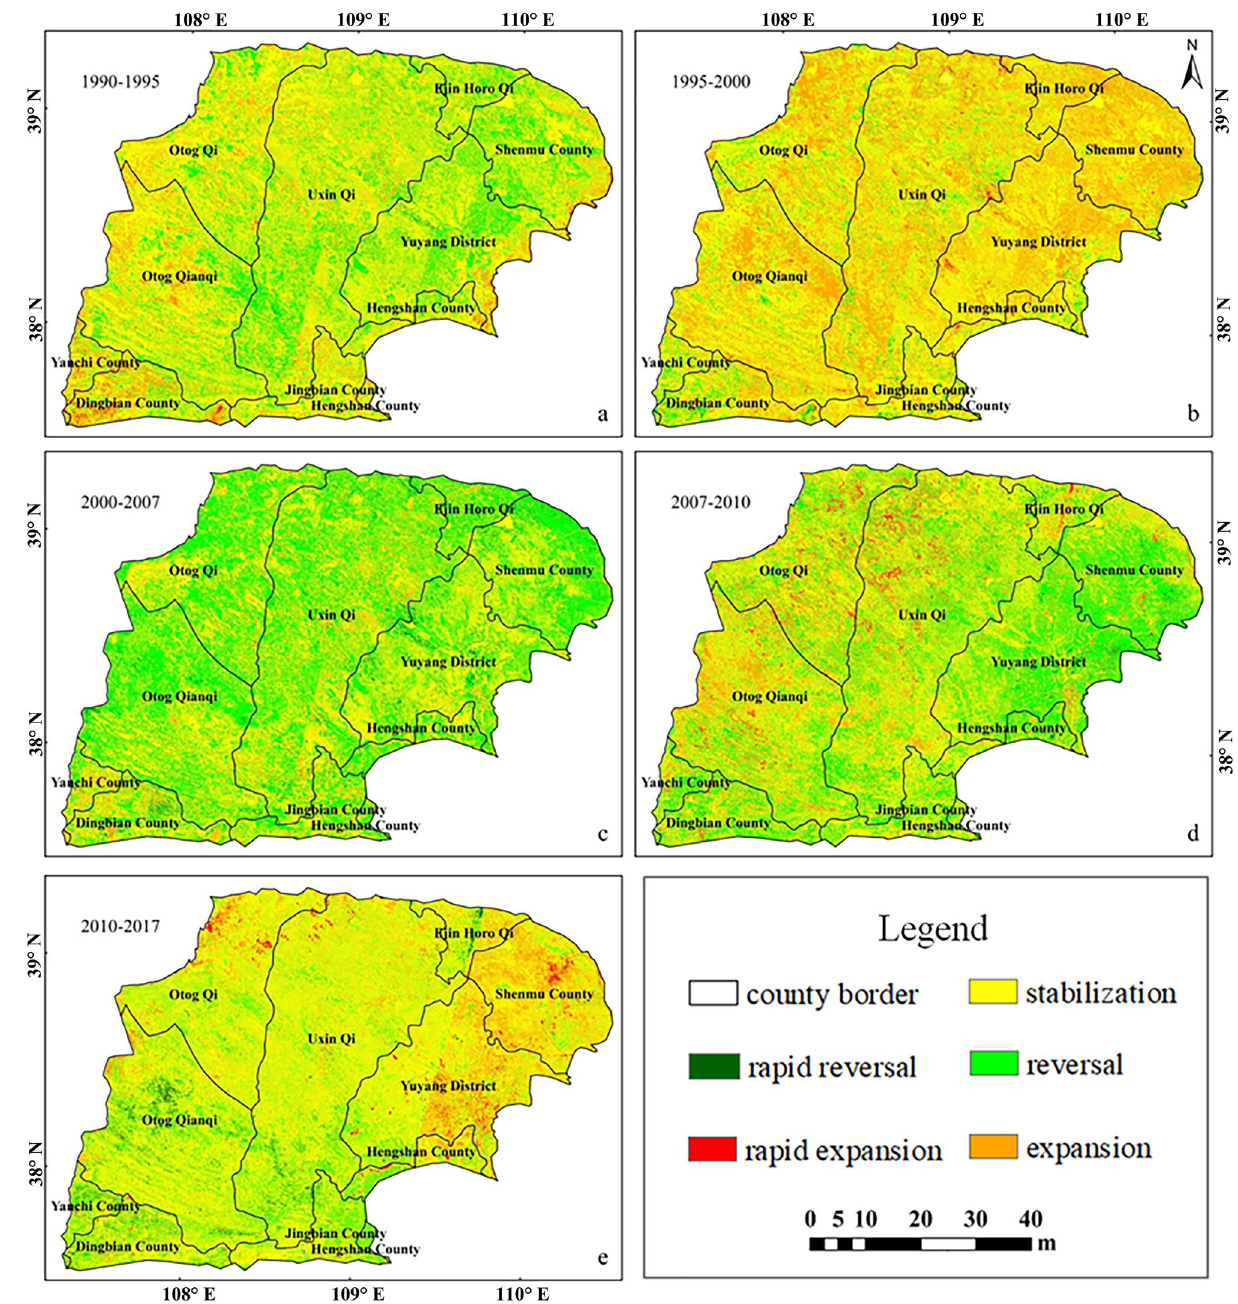
Figure 5. Dynamic changes in desertification in the Mu Us Sandy Land in the last 30 years: changes during ( a ) 1990–1995, ( b ) 1995–2000, ( c ) 2000–2007, ( d ) 2007–2010, ( e ) 2010–2017, legend definitions based on the degree of desertification as follows: rapid reversal (the degree of desertification declined by more than one grade); reversal (declined by one level); stable (degree not changed); expansion of desertification (increased by one level); rapid expansion (increased by more than one